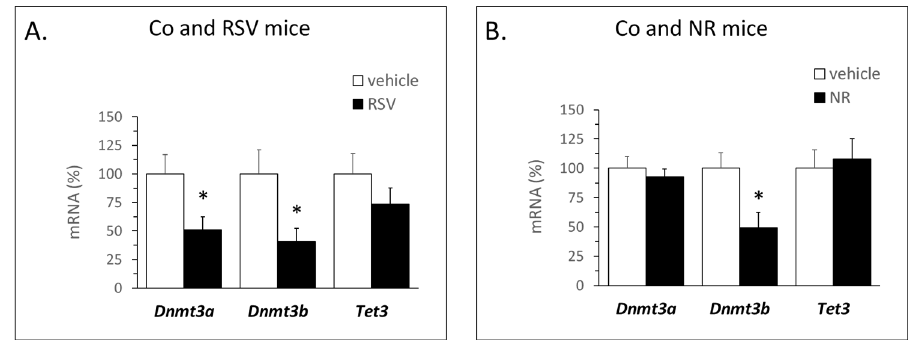
Figure 5. mRNA levels of DNA methylation-related genes Dnmt3a , Dnmt3b, and Tet3 in inguinal WAT of young (35-day-old) male mice treated orally with vehicle (control), resveratrol (RSV, A ) or nicotinamide riboside (NR, B ) during the suckling period. Data: mean ± SEM of n = 5–6 animals per group (mean value in controls set at 100%). Statistics: * p < 0.05, effect of treatment, Student’s t -test.